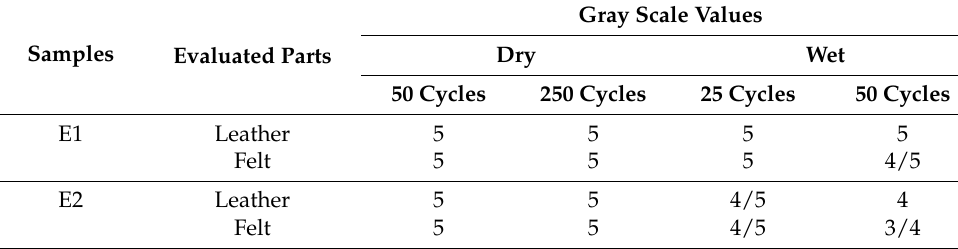
Figure 7. The SEM images of the cross-sections of finished leathers at different magnifications. Table 4. Rubbing fastness properties of leather samples coated with copolymer latexes.